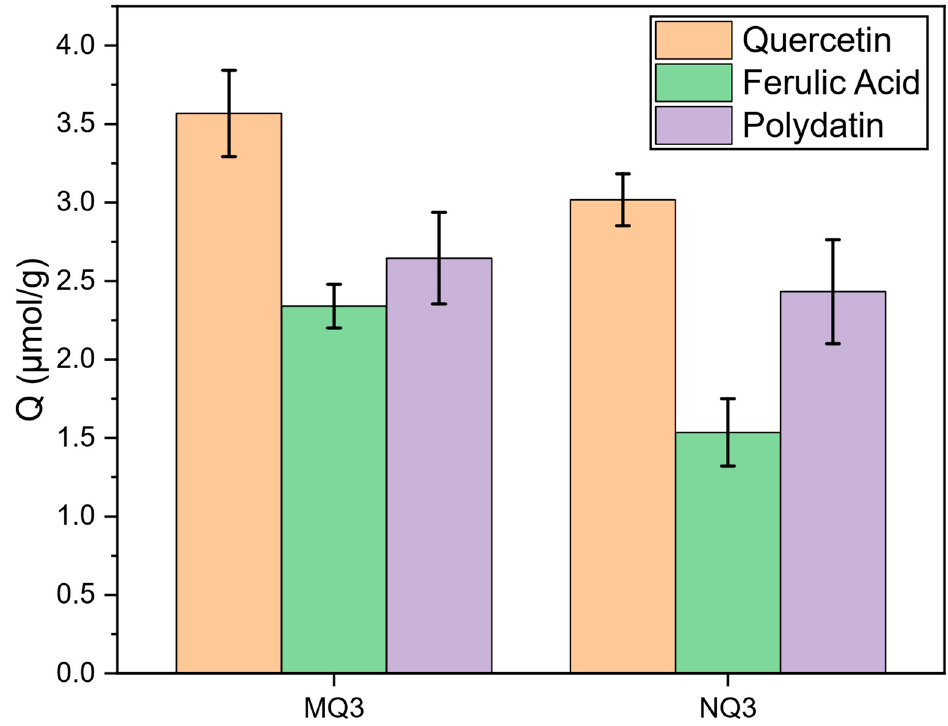
Figure 5. Batch adsorption results in 8/2 EtOH/Water using 0.2 mM of quercetin, polydatin or ferulic